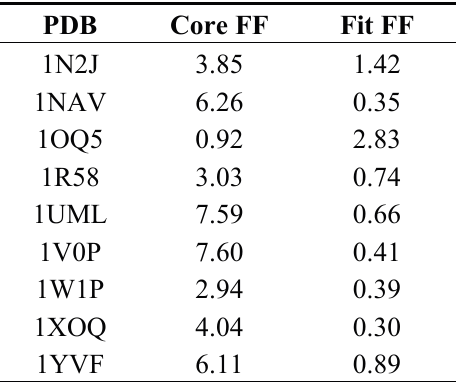
Table 5. RMSD of top-ranked poses for Core FF and Fit FF from complexes discussed in the dedicated chapter (Core vs.